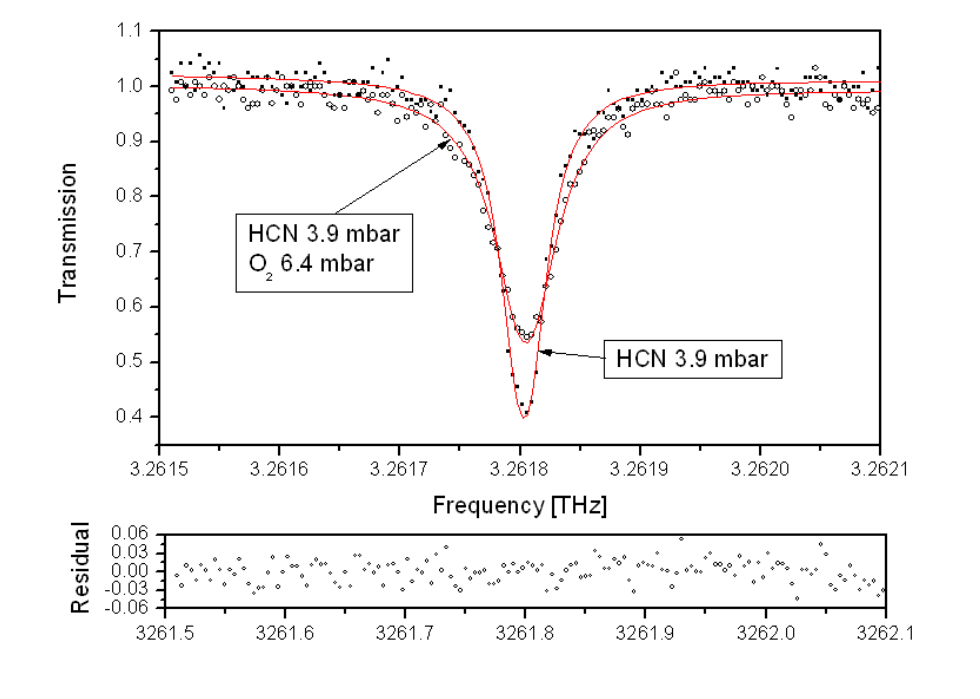
Figure 8. Transmission spectra of HCN at ambient temperature for J = 37 ← 36 . Red line fitted absorption